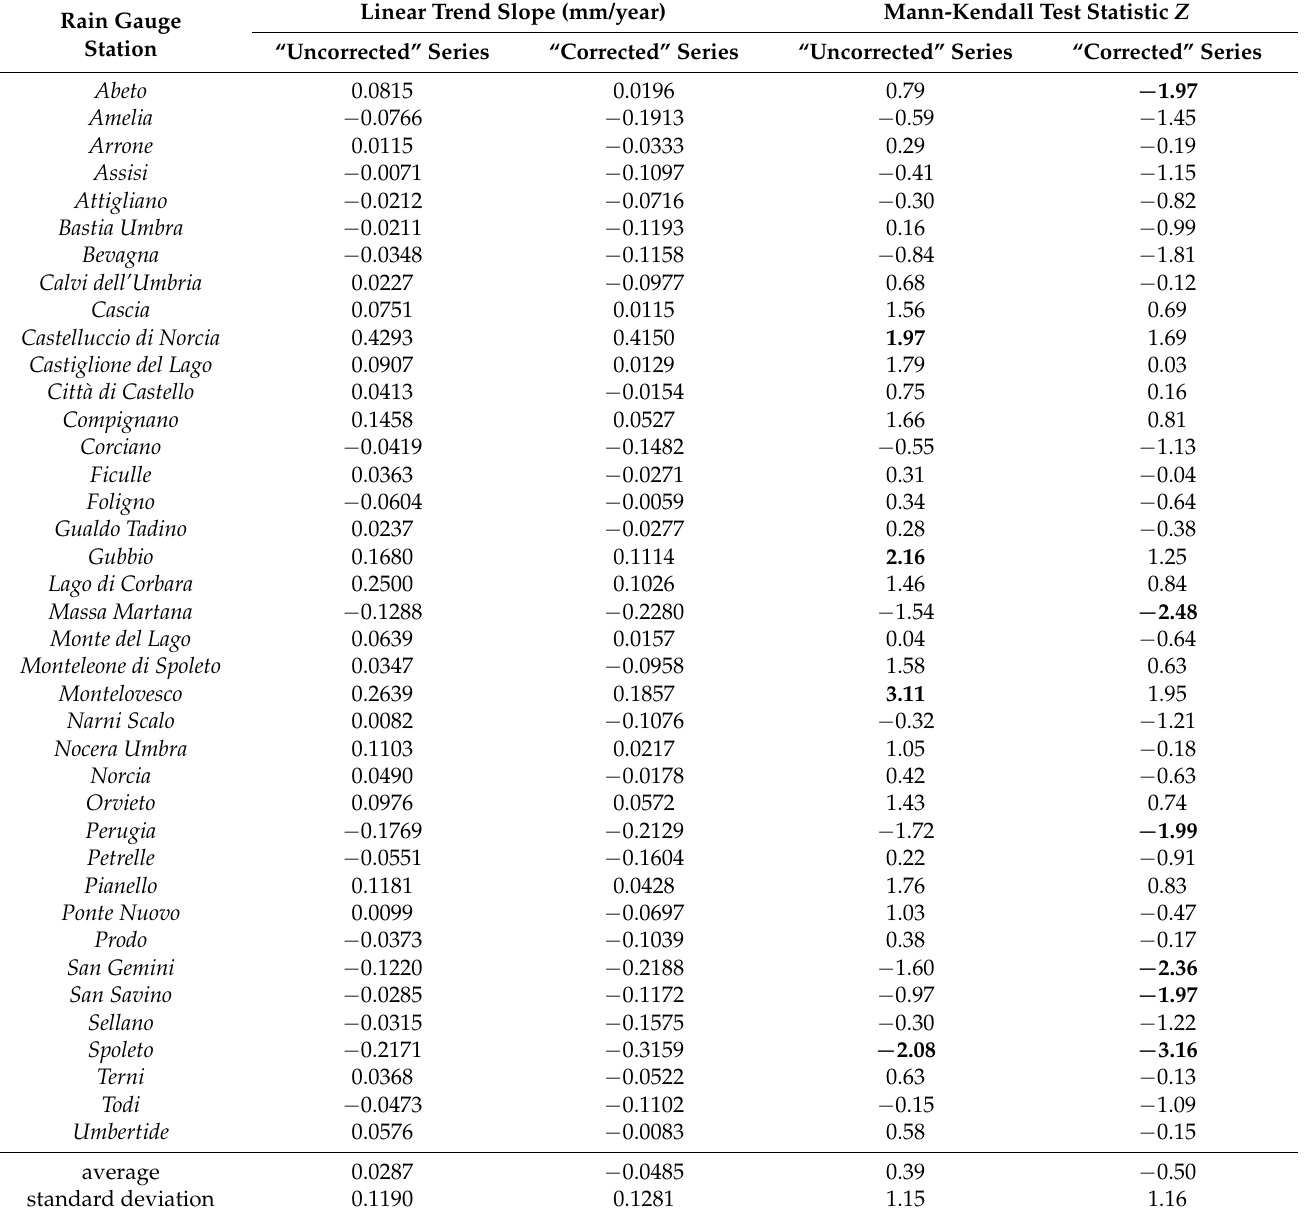
Table 5. Slope (in mm/year) of the least-squares linear regressions and Mann–Kendall test statistic Z of annual maximum rainfall depths for the selected stations and for duration 24 h, for the “uncorrected” and “corrected” series. For the Mann–Kendall test statistic Z , in bold the cases with significant